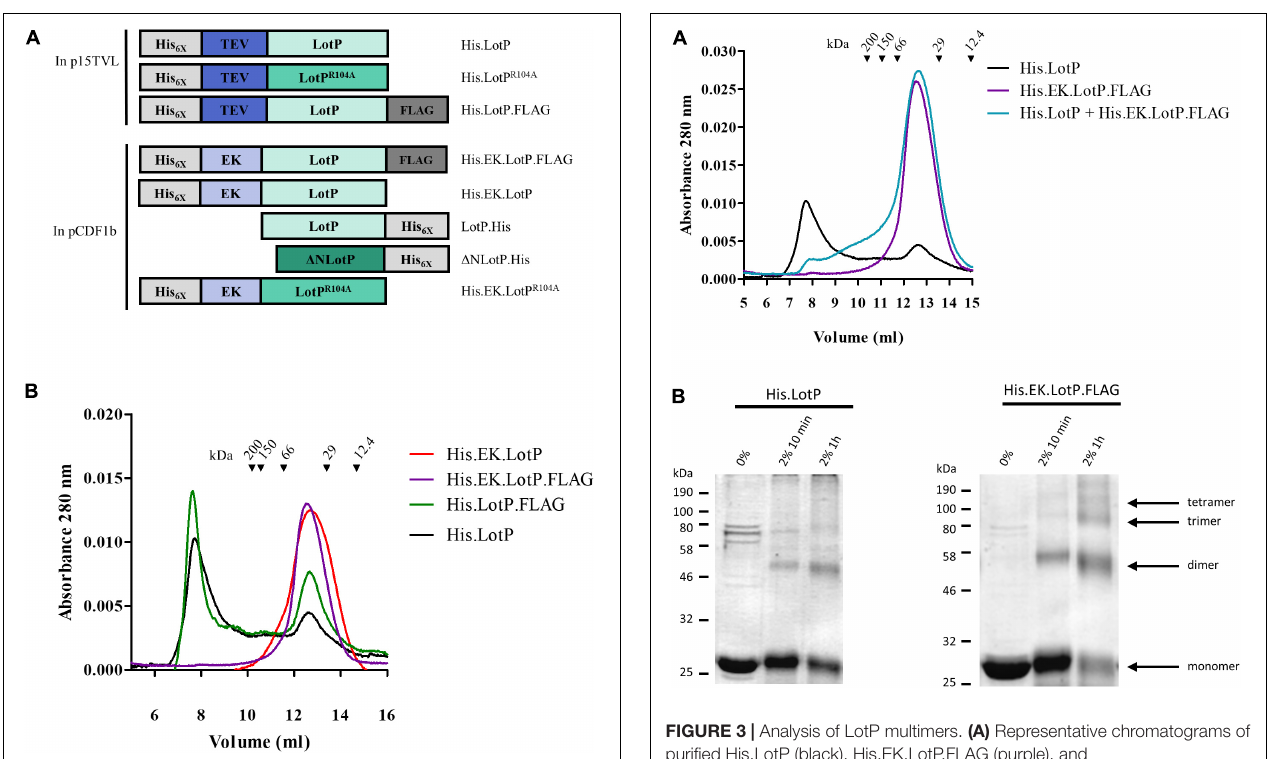
FIGURE 2 | Modifications to LotP and its effect on dimerization. Schematic representation of different LotP constructions. (A) Protein tags (His 6X and FLAG) are shown in shades of gray, cleavage sites (TEV and EK) in shades of blue, and LotP protein constructs (LotP, LotP R104A , and (cid:49) NLotP) in shades of green. (B) Representative chromatogram of purified His.EK.LotP (red), His.EK.LotP.FLAG (purple), His.LotP.FLAG (green), and His.LotP (black) analyzed by size-exclusion chromatography using a Superose 12 column. The purified proteins were separate according to its native molecular size. The elutions were monitored continuously at 280 nm, and the graphic shows the signal at the different elution volumes.